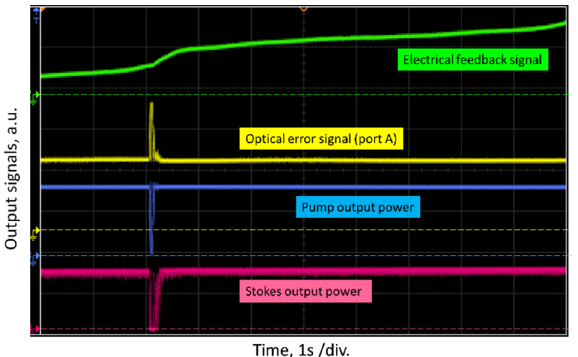
Figure A4. Typical oscilloscope traces of the optical error signal (port A), pump, and Stokes output powers and electrical feedback signal, highlighting the response to a pencil knock on the laser box.